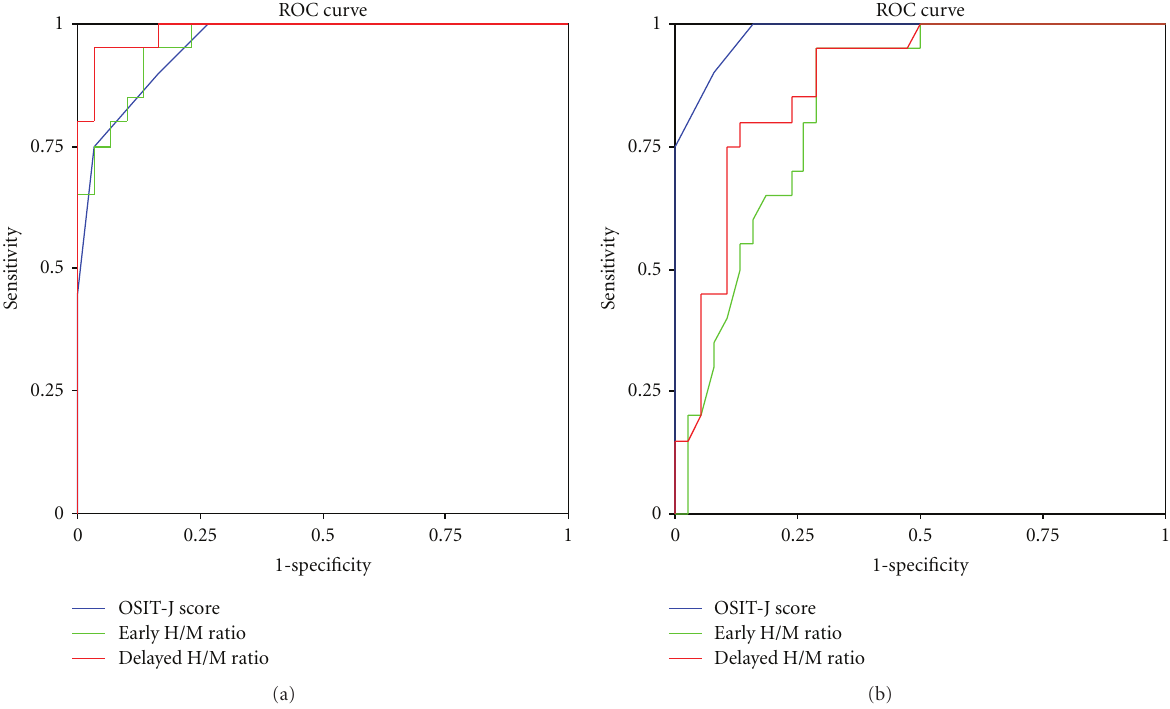
Figure 1: (a) ROC analysisof the early or delayed H/M ratio and odor identification showed an area under the curve of 0.96 (95% CI = 0 . 92– 1 . 00, P = . 000), 0.99 (95% CI = 0 . 96–1 . 00, P = . 000), and 0.96 (95% CI = 0 . 91–1 . 00, P = . 000) for iRBD. (b) ROC analysis of the early or delayed H/M ratio and odor identification showed an area under the curve of 0.84 (95% CI = 0 . 74–0 . 94, P = . 000), 0.88 (95% CI = 0 . 79– 0 . 97, P = . 000), and 0.98 (95% CI = 0 . 96–1 . 00, P = . 000) for PD.